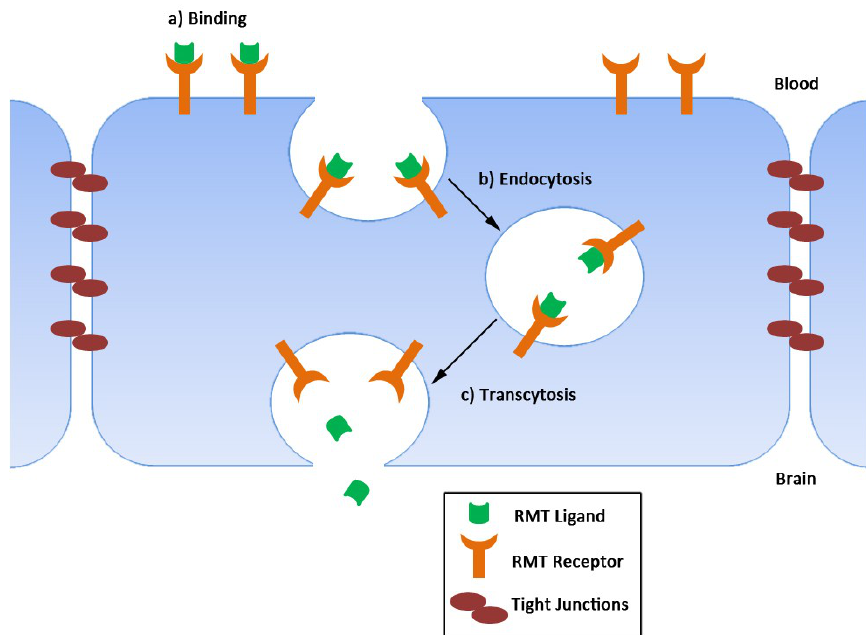
Figure 2. Representation of the receptor-mediated transcytosis (RMT) process. ( a ) Initially, an RMT ligand binds to a specific RMT receptor on the luminal cell membrane, which ( b ) leads to the internalization of both receptor and ligand in intracellular vesicles via endocytosis. ( c ) These vesicles then travel within the cell cytoplasm to reach the abluminal membrane where fusion of endosomes with the cell membrane releases the vesicular cargo inside the brain.